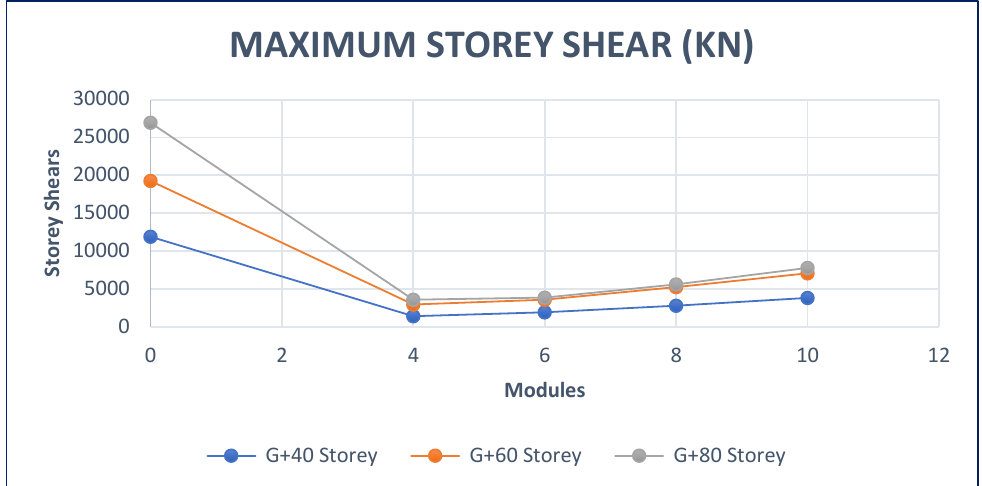
Fig. 3 Maximum Storey Shear In Kn.